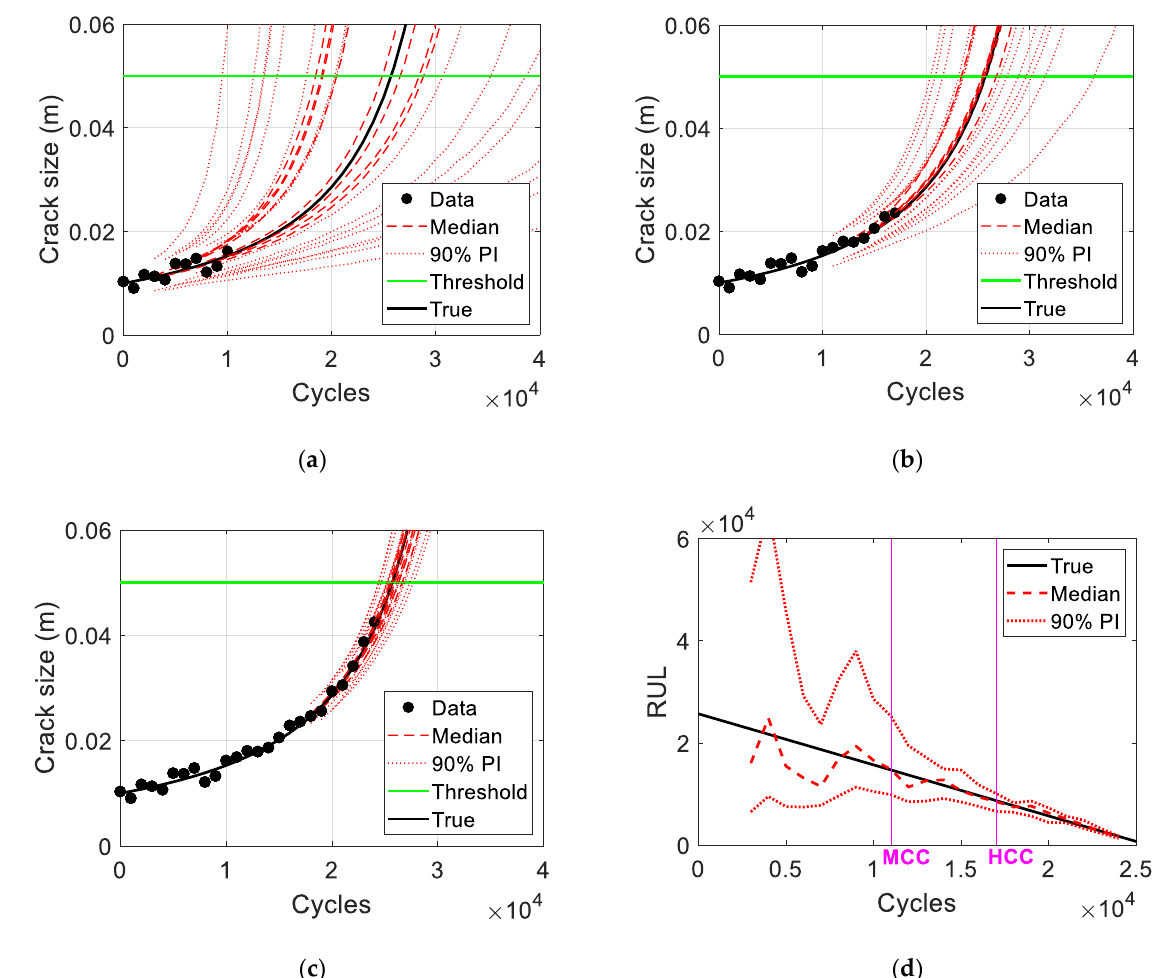
Figure 6. Validation of the credibility criteria: small level of noise. ( a ) Zone 1 (before MCC), ( b ) Zone 2 (between MCC and HCC), ( c ) Zone 3 (after HCC), ( d ) RUL prediction result.